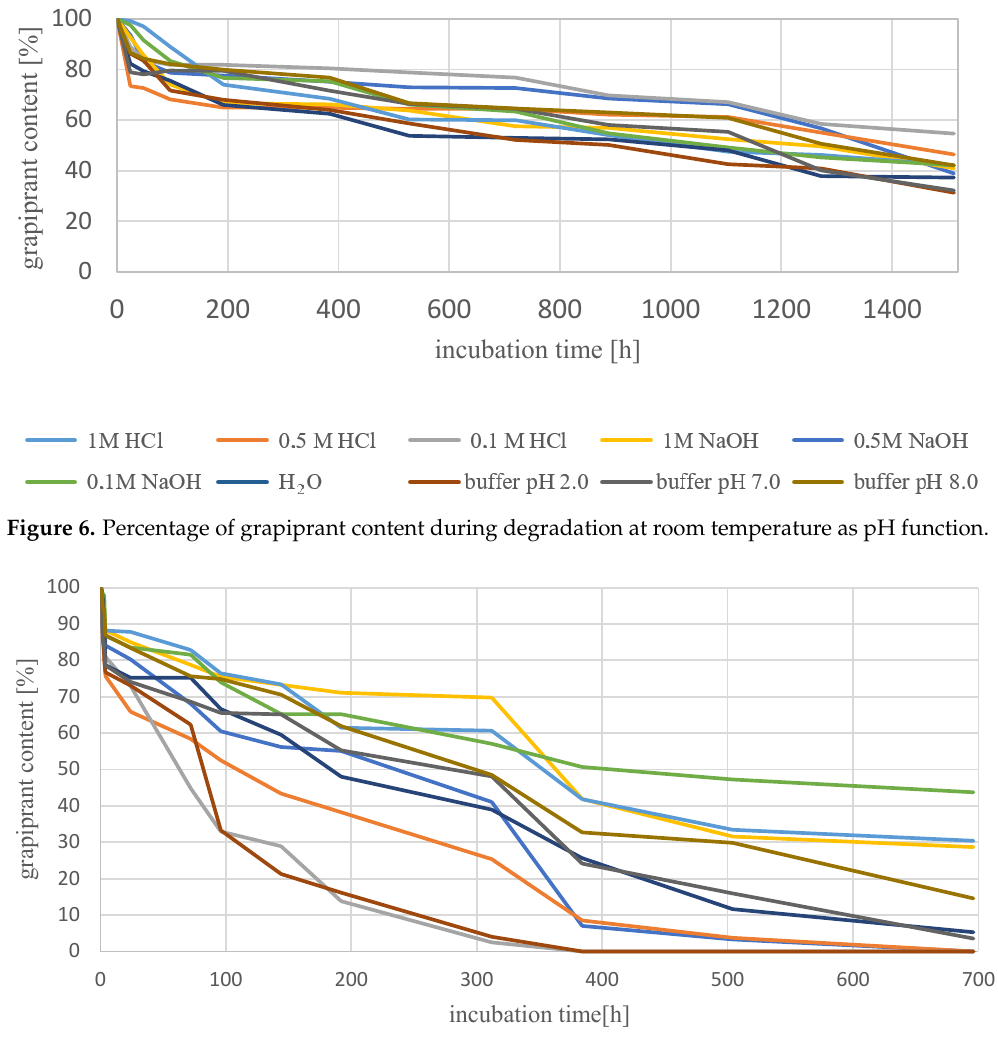
at room temperature.